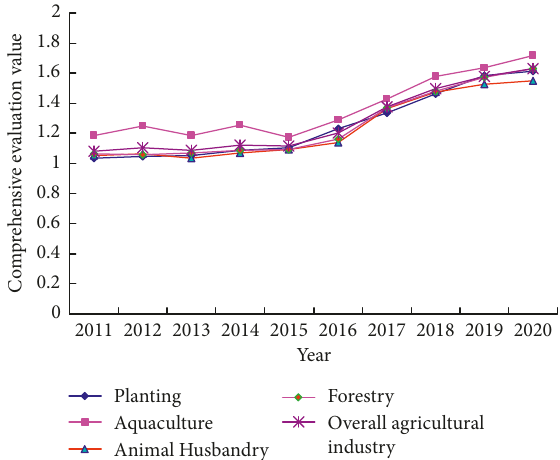
Figure 8: Comprehensive evaluation results before and after op- timization of each subsystem of ecological agriculture industry